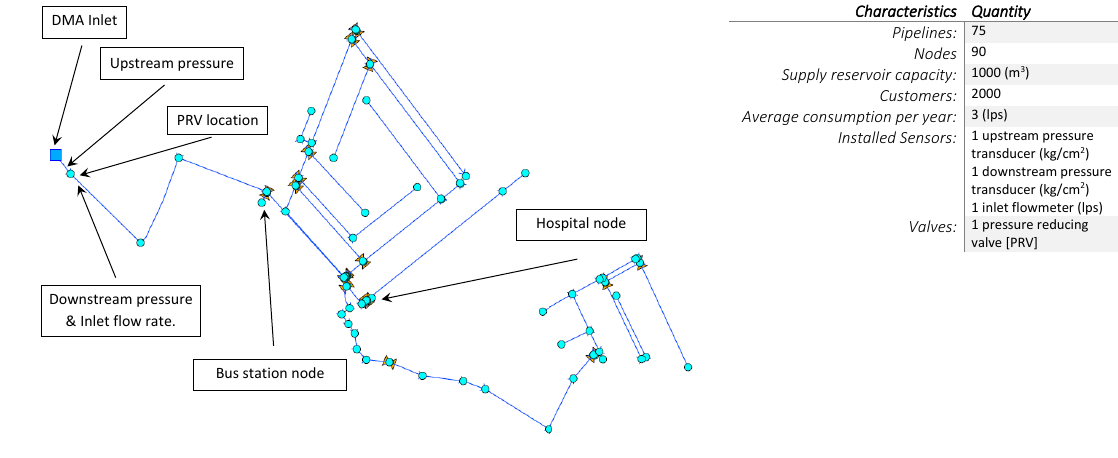
Figure 1. EPANETlayout of the District Metered Area (DMA) El Charro. PRV, Pressure Reducing